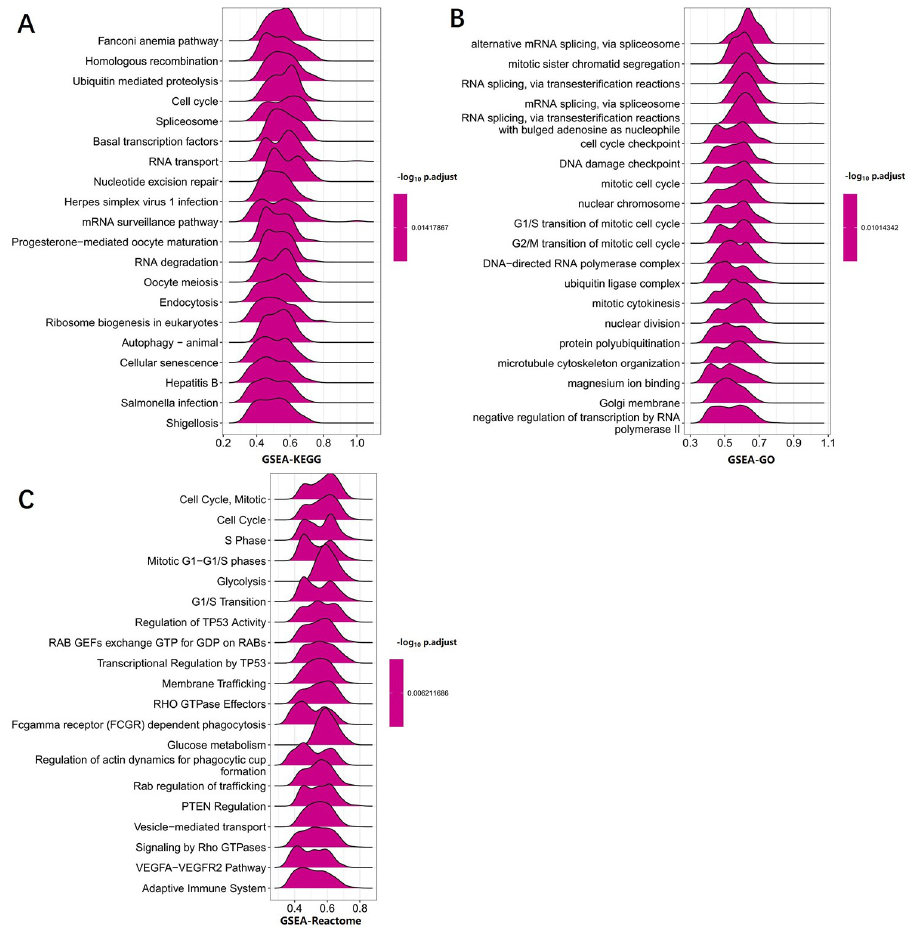
Fig 6. GSEA analysis revealed the pathway enriched in UPF3B high and low expression phenotype. (A) GSEA analysis in KEGG gene sets. (B) GSEA analysis in GO gene sets. (C) GSEA analysis in ReactomE gene sets. Data was obtained via TCGA-LIHC. Only gene sets with NOM p < 0.05 and FDR q < 0.06 were considered significant.